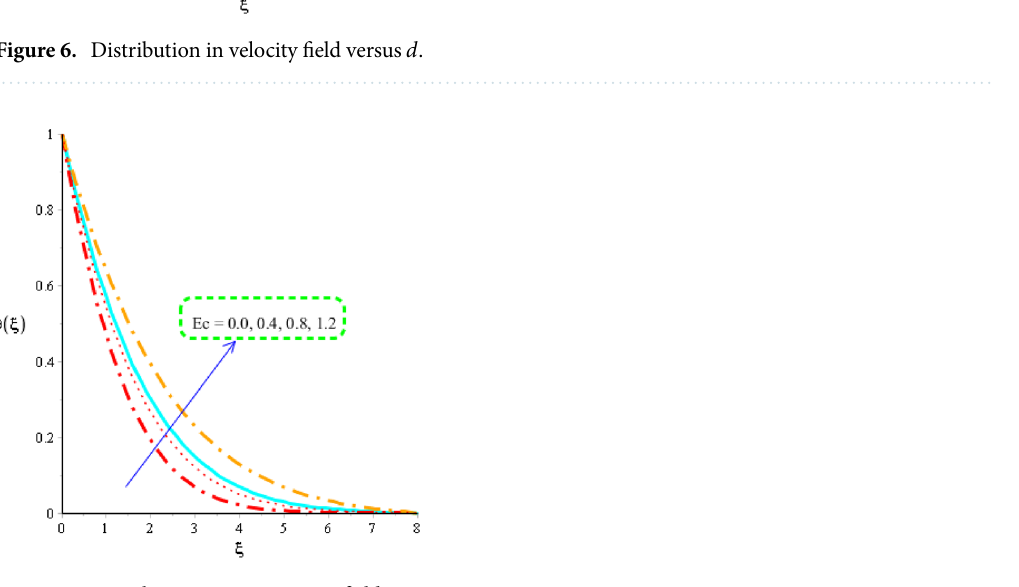
Figure 7. Distribution in temperature field versus Ec